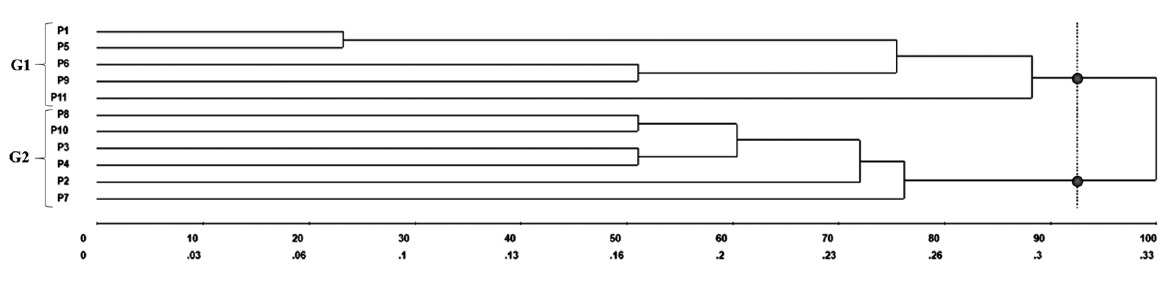
Figure 2. Dendrogram representative of genetic dissimilarity based on the complement of the weighted index in the eleven conilon coffee parents, obtained by UPGMA using the program Genes, forming two groups. The dotted line delimits the formed groups, with cut-off at approximately